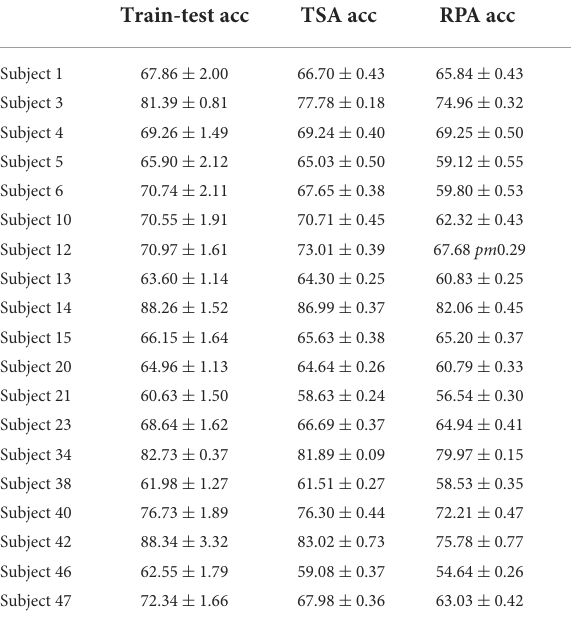
TABLE 2 Balanced accuracy ± standard error for the good subjects of database Cho 2017 averaged over number of alignment trials and source for train-test, TSA, and RPA.